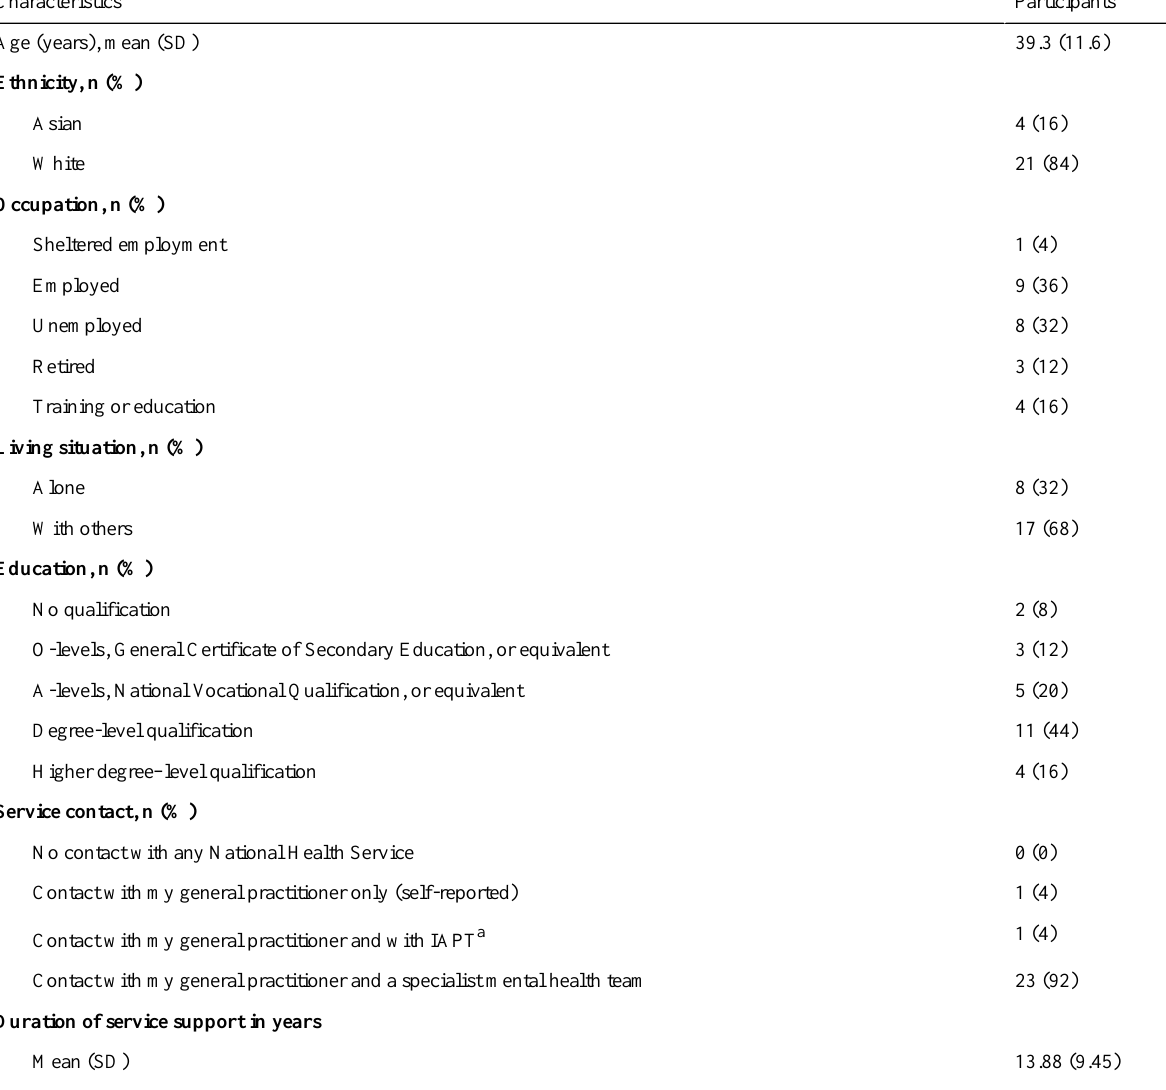
Table 3. Characteristics of participants of study 4